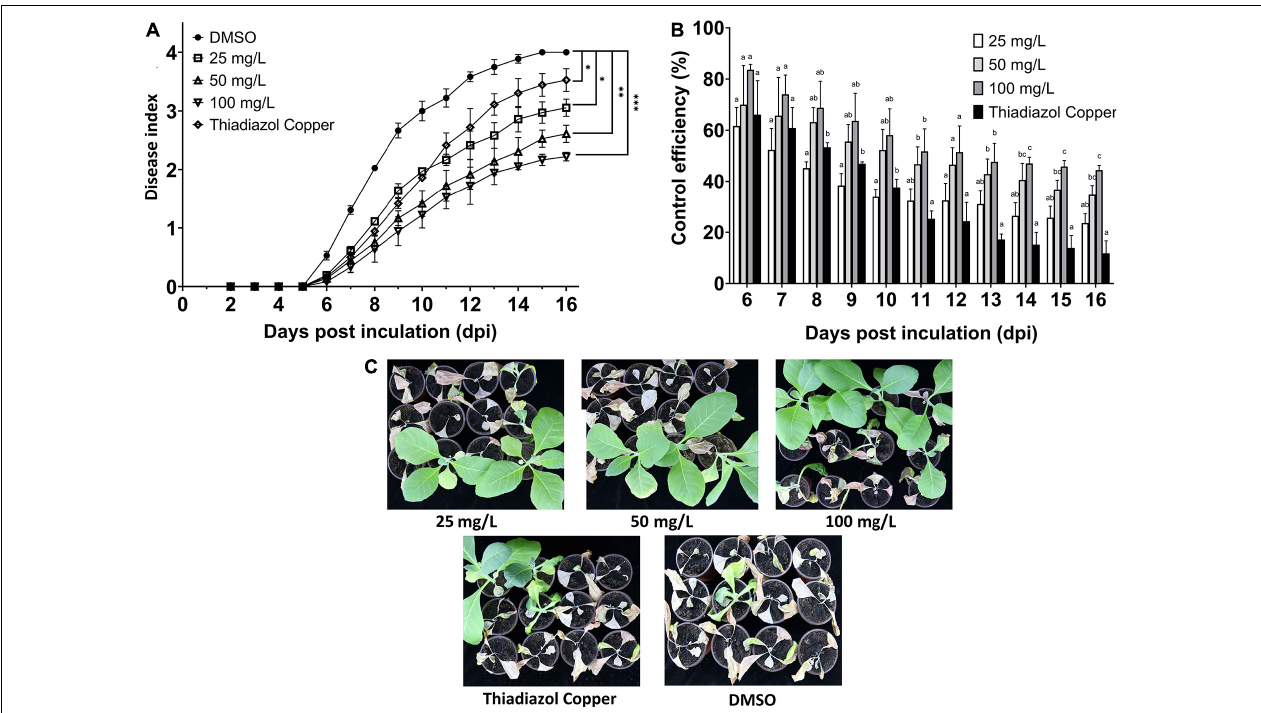
FIGURE 7 | Relative control effects of each treatment on pot experimental tobacco seedlings. (A) :The disease index of tobacco wilt treated with 25, 50, and 100 mg/L 7-methoxycoumarin. (B) The control effect of 7-methoxycoumarin. (C) The control effect after 16 days of inoculation with R. solanacearum (* indicates p < 0.05, ** indicates p < 0.01, and *** indicates p < 0.001). Different lowercase letters on the histogram of the same group indicate significant differences between different treatments, p <